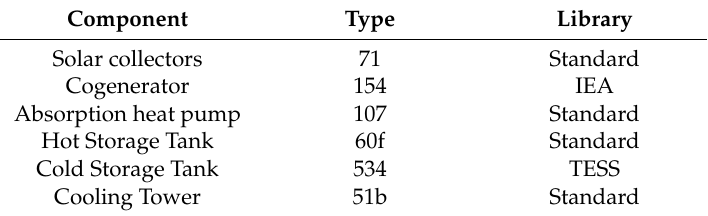
Table 2. Hybrid solar-assisted trigeneration plant components and related TRNSYS types.